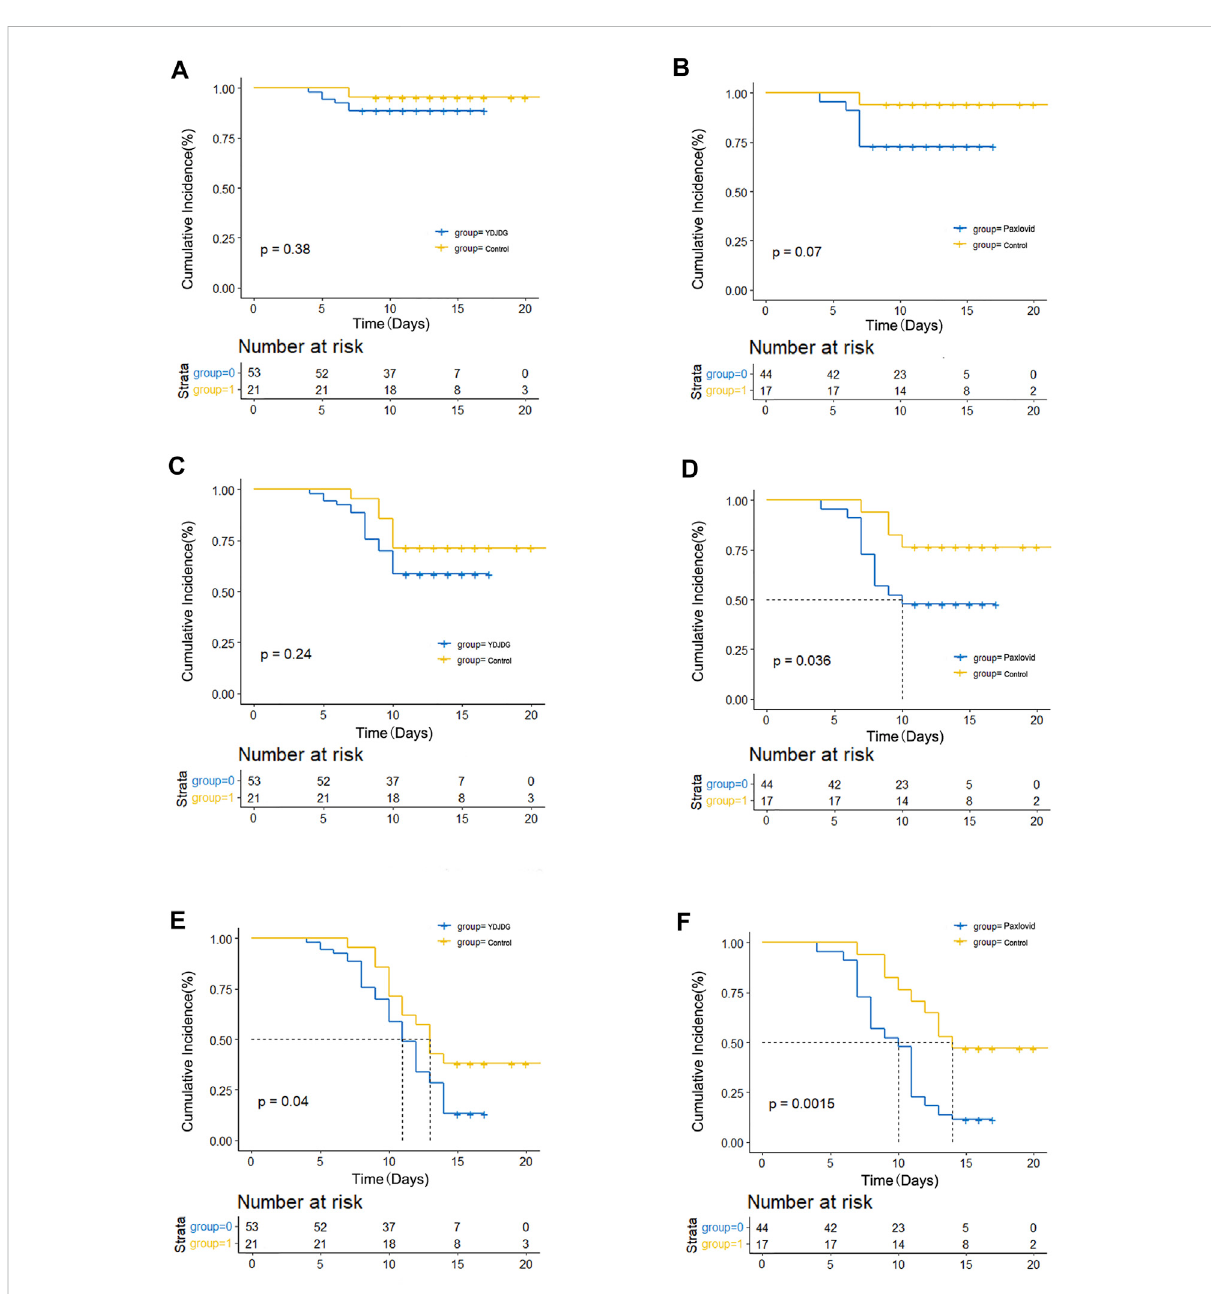
FIGURE 4 Kaplan – Meier estimates of proportion recovery. Proportion recovery estimates are shown in patients after PSM. The nucleic acid shedding proportion was compared between the YDJDG and the control group after a follow-up of 7 days (A) , 10 days (C) , and 14 days (E) . The nucleic acid shedding proportion was compared between the Paxlovid and thecontrol group after afollow-upof7 days (B) , 10 days (D) , and 14 days (F) . YDJDG, Yindan Jiedu granules; PSM, propensity score